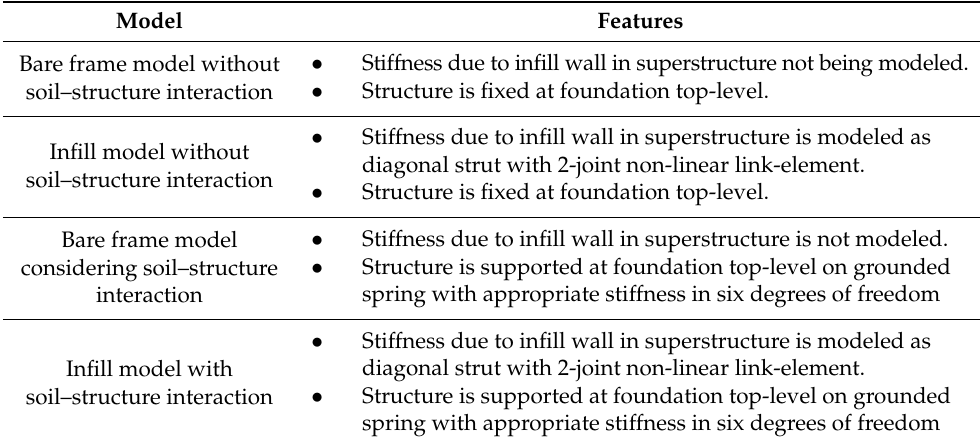
Table 3. Acceleration time histories used for analysis.